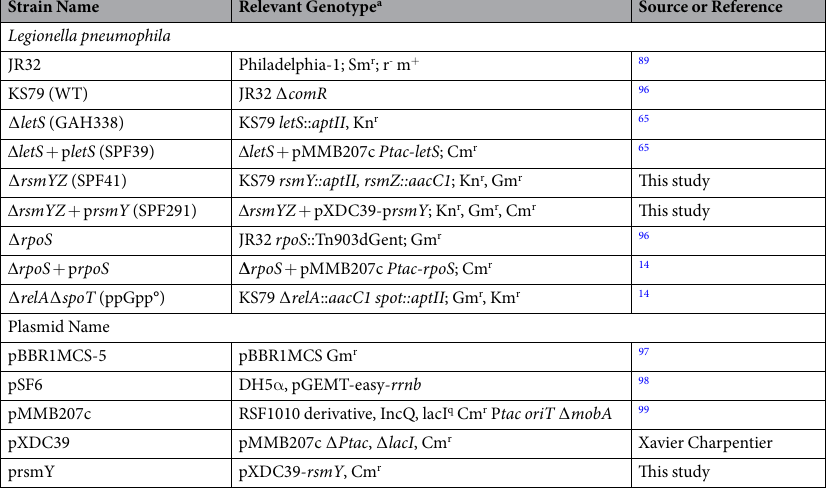
Table 2. Strains used in this study. a Sm r , streptomycin resistance; Cm r , chloramphenical resistance; Gm r , gentamicin resistance; Km r , kanamycin